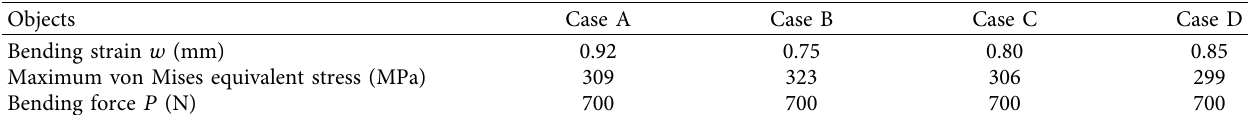
Table 12: Results of computer simulation of the elastic deformation in the plates (with a load of 700N).